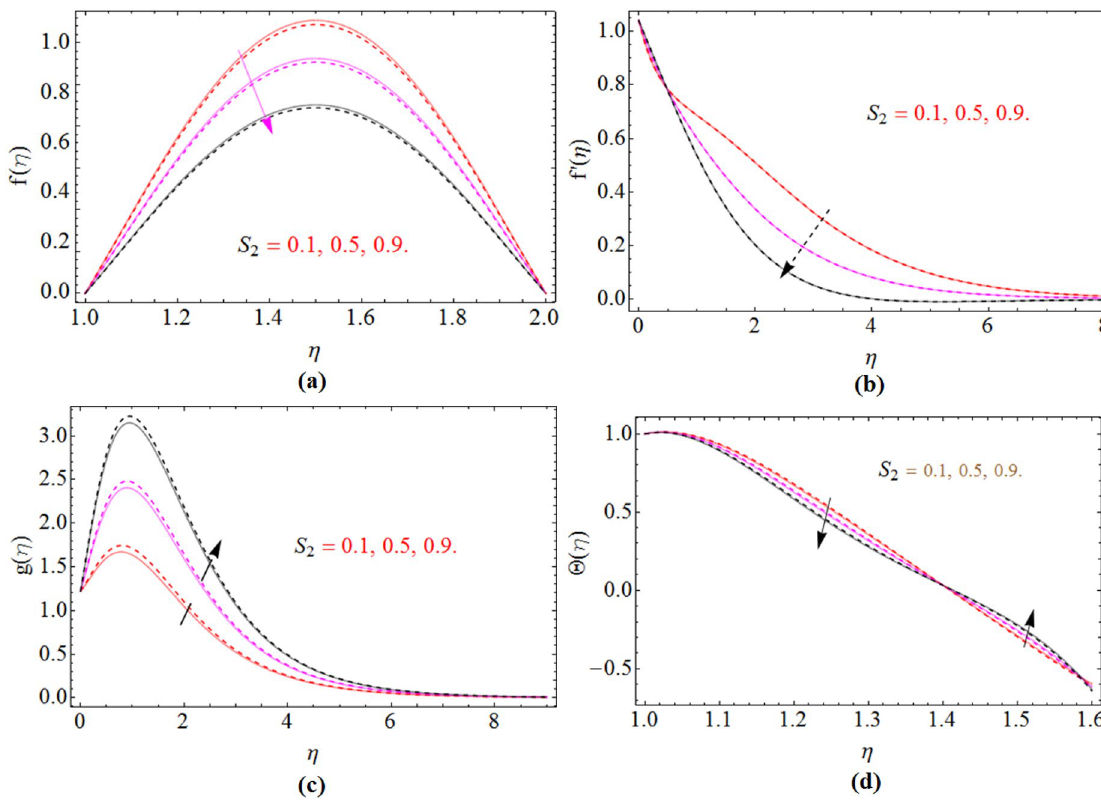
Figure 5. S 2 impact on axial f (η) , radial f ′ (η) and azimuthal velocity g (η) and temperature profile �(η) , for S 2 , when S 1 = 0.0. dashed lines for (cid:31) = 0.5 and lines for (cid:31) = −